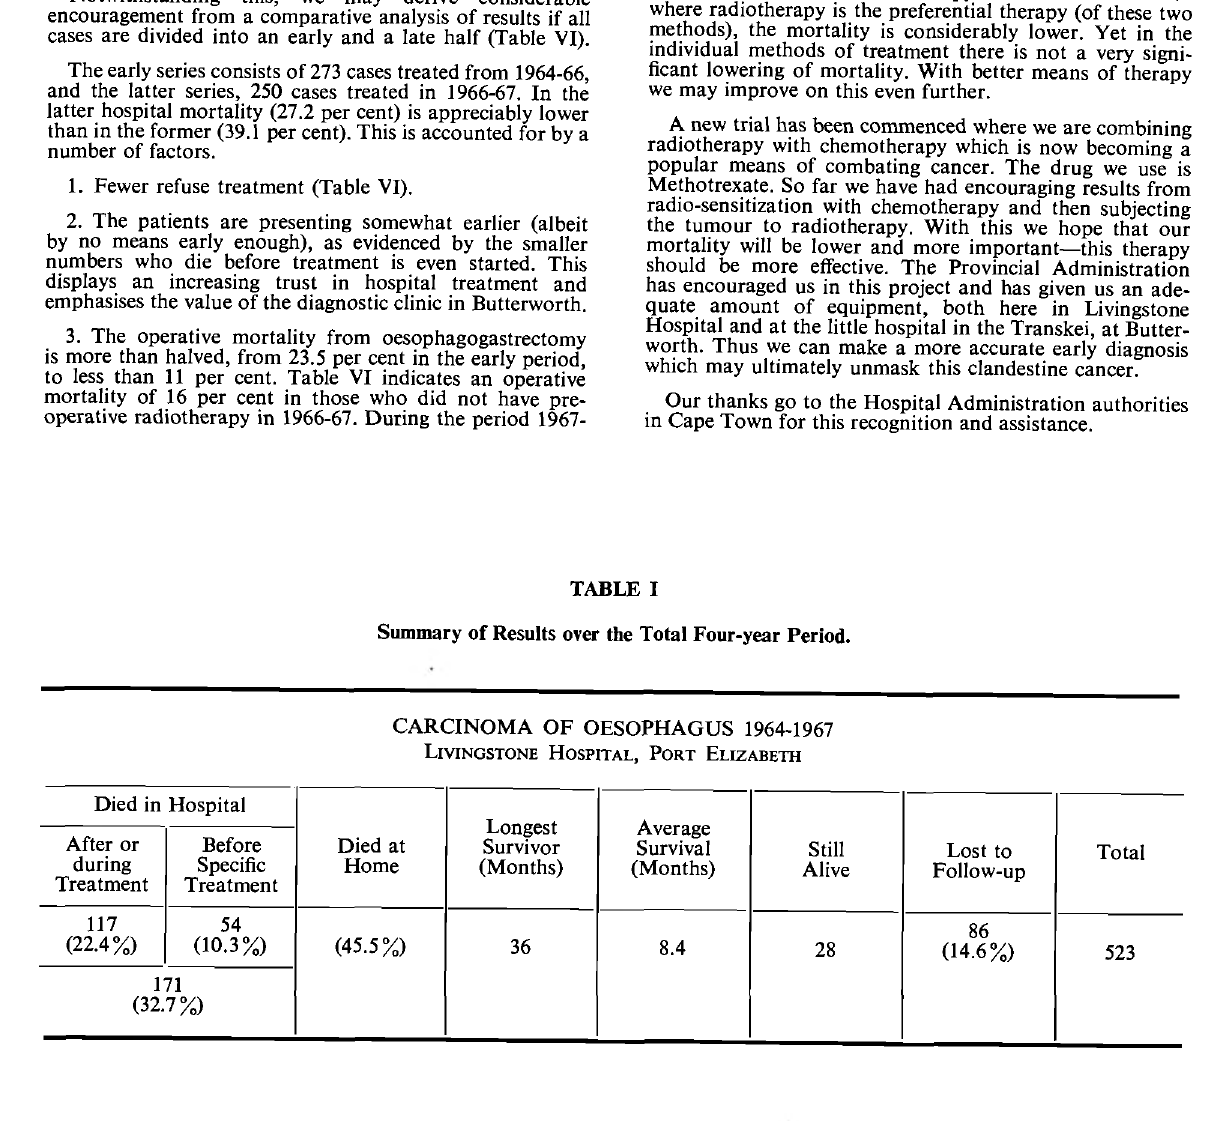
Summary of Results over the Total Four-year